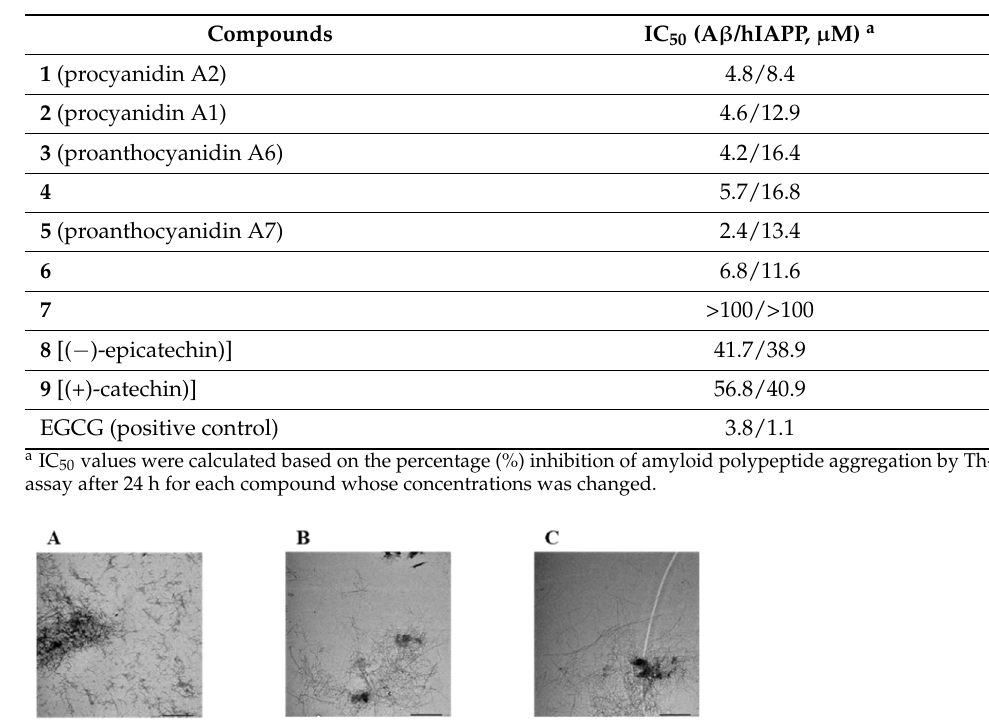
Table 1. Efficacy of compounds 1–9 against A β and hIAPP aggregations.